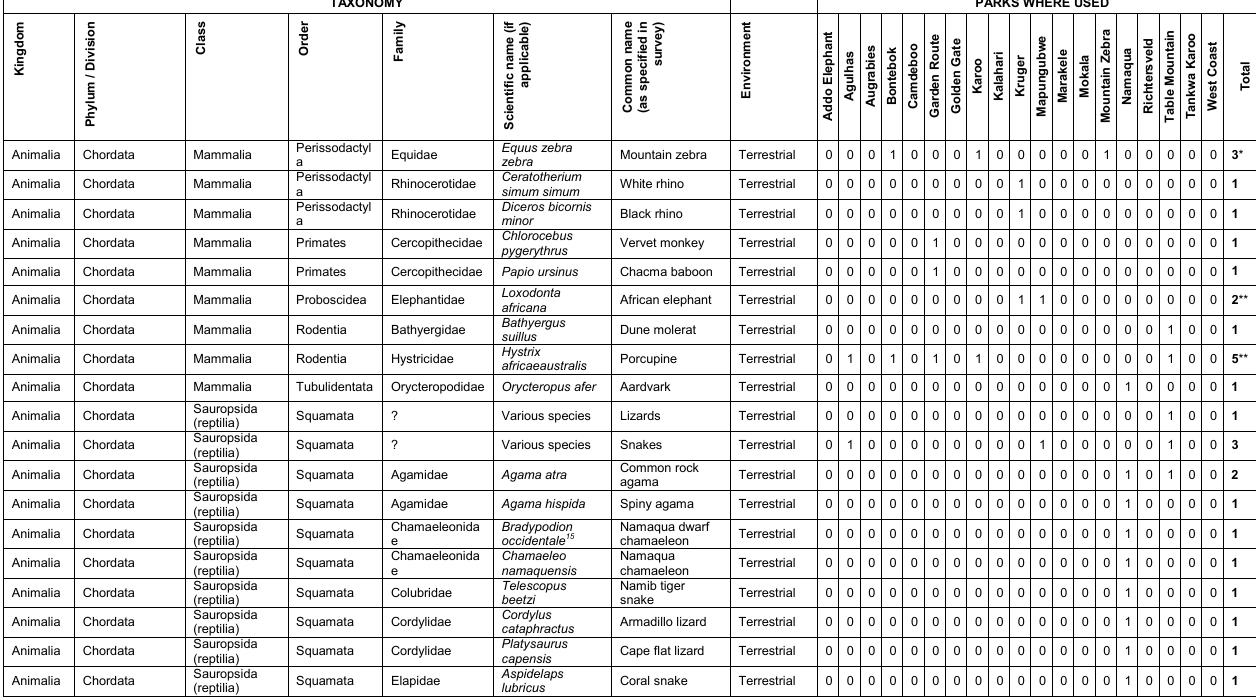
TAXONOMY PARKS WHERE USED